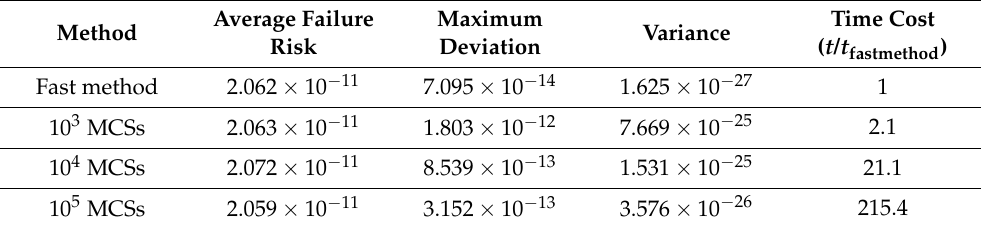
Figure 10. Failure risk results using different methods and different numbers of calculations. Table 3. Statistical results after repeated calculations by different